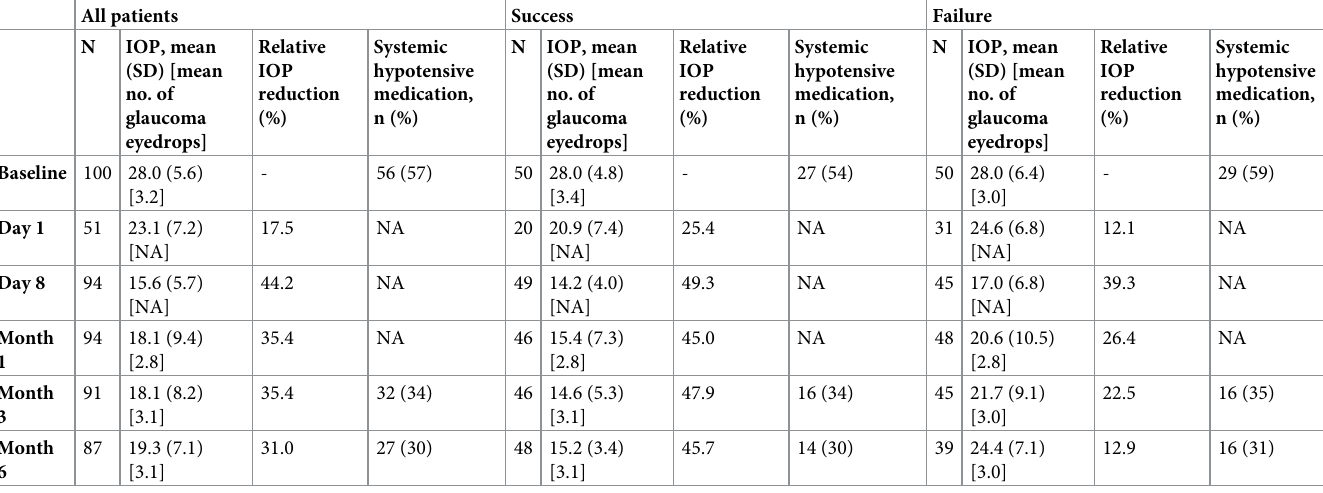
Table 2. Intraocular pressure and hypotensive medications at baseline and follow-up. All patients